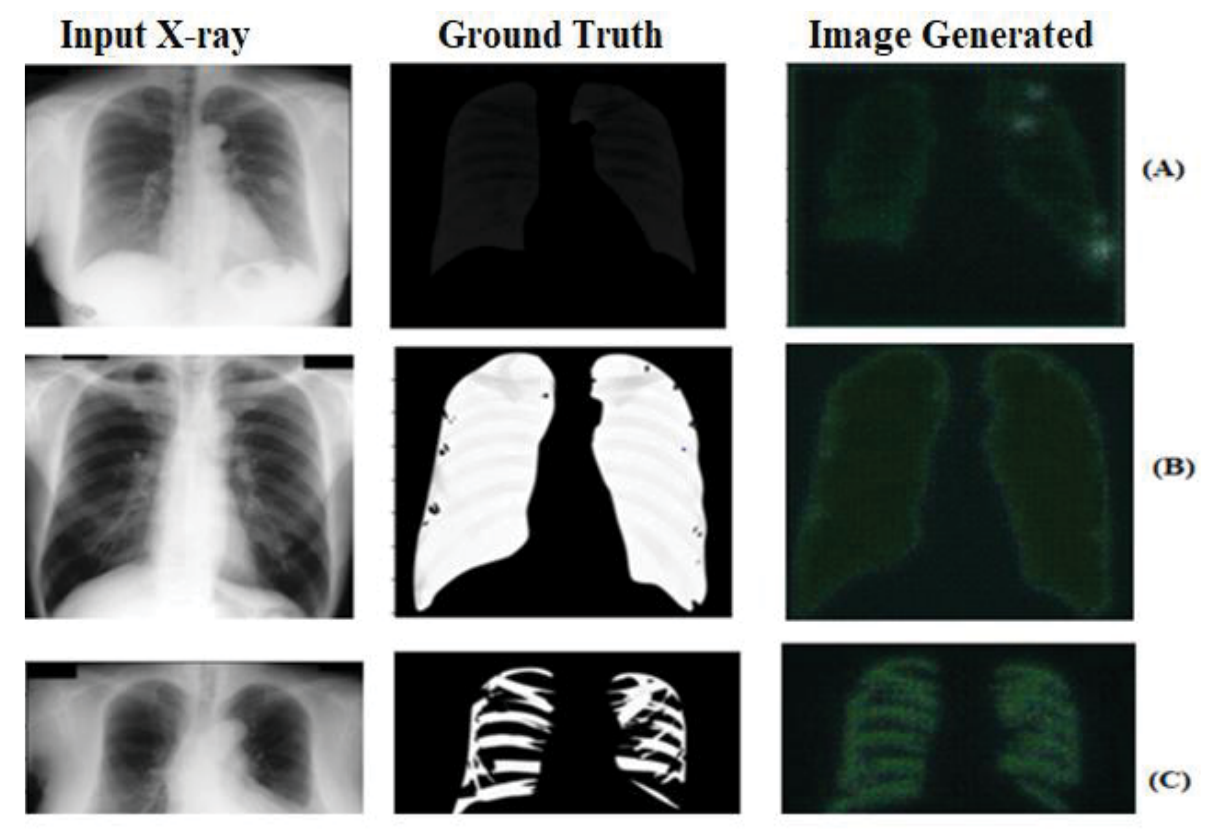
FIGURE 5 (cid:2)(cid:2)(cid:2)(cid:2)(cid:2)(cid:2) RESULTS CASES FOR OVER-SEGMENTATION AND UNDER-SEGMENTATION. AS CAN BE SEEN IN INPUT IMAGES, SHOW A SLIGHT UNDER SEGMENTATION IN (A) DUE TO SOME LOW VARIANCE IN THE LEFT LUNG. IN(B), THE AREA AROUND THE LUNGS SHOWS A REGULAR INTENSITY VARIATION, RESULTING IN OVER-SEGMENTATION. (C) SEGMENTATION CAN BE SEEN AS THE BEST PERFORMANCE.